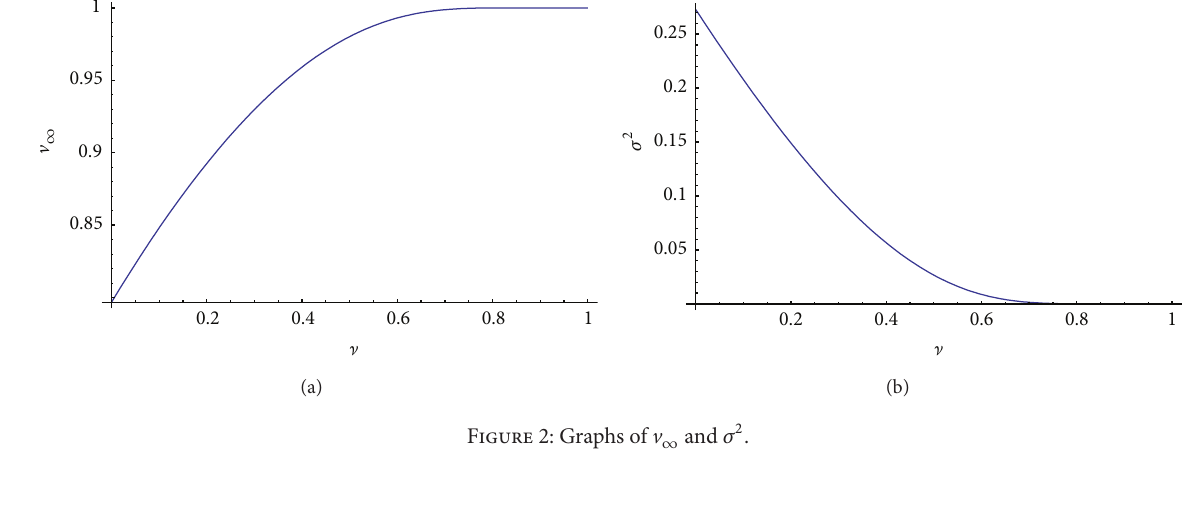
Figure 2: Graphs of V ∞ and 𝜎 2